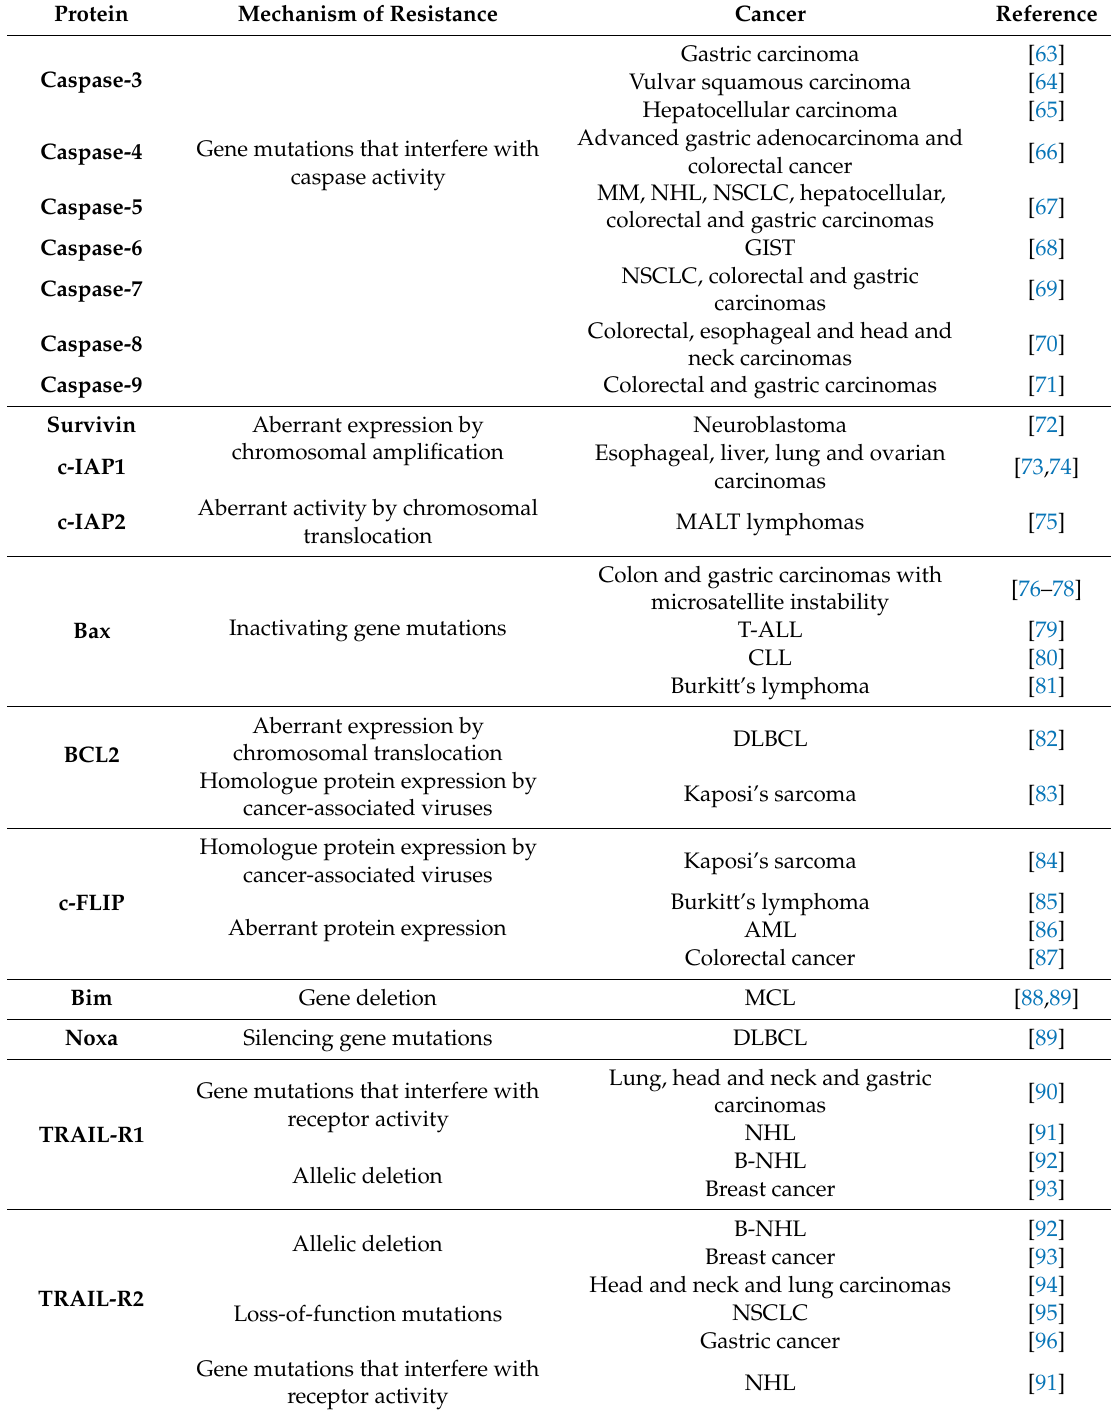
Table 2. Mechanisms of resistance to NK cell-mediated